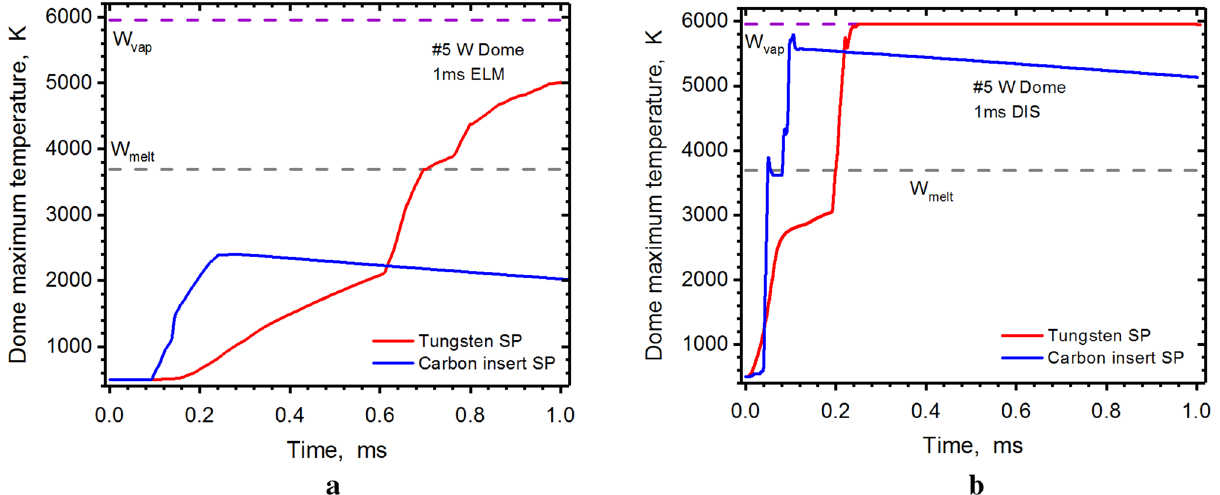
Figure 4. HEIGHTS simulation of PFC transient response: Dome maximum surface temperature during 1.0 ms ELM ( a ), 1.0 ms disruption ( b ), see Fig. 1b for surfaces location. Tungsten SP (red), carbon insert at SP (blue). The images were prepared using OriginPro V2020.